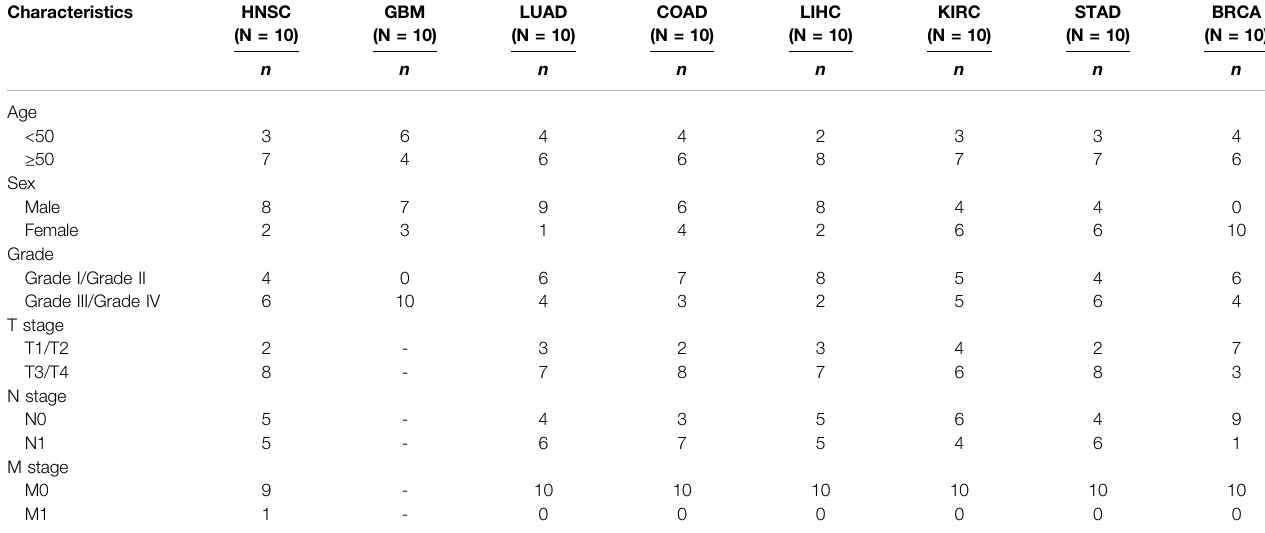
TABLE 1 | Baseline clinicopathological characteristics of patients.